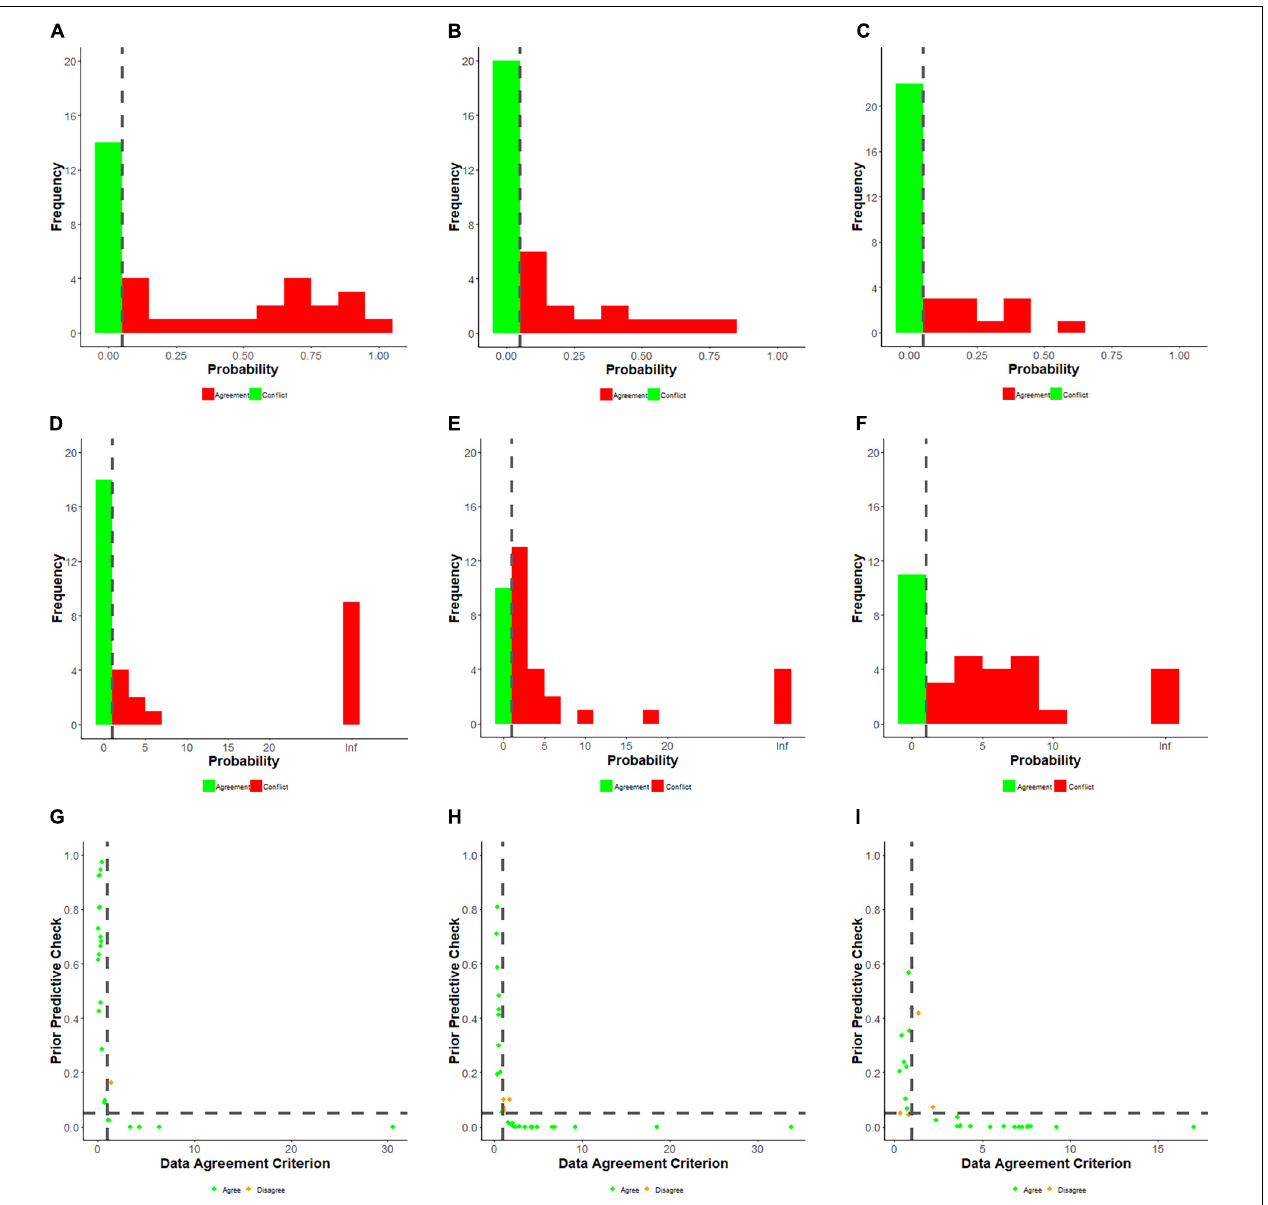
FIGURE 4 | Results for the prior predictive check (A–C) , the DAC (D–F) , and for the combination of the two (G–I) for each scenario separately. The dotted line represents the cut-off values used. The green dots in (G–I) , indicate identical conclusions for both measures, and the orange dots indicate numerical differences. It should be noted all of these are boundary cases, for example, a PPC of 0.049 (conflict) and a DAC score of 0.98 (no conflict).